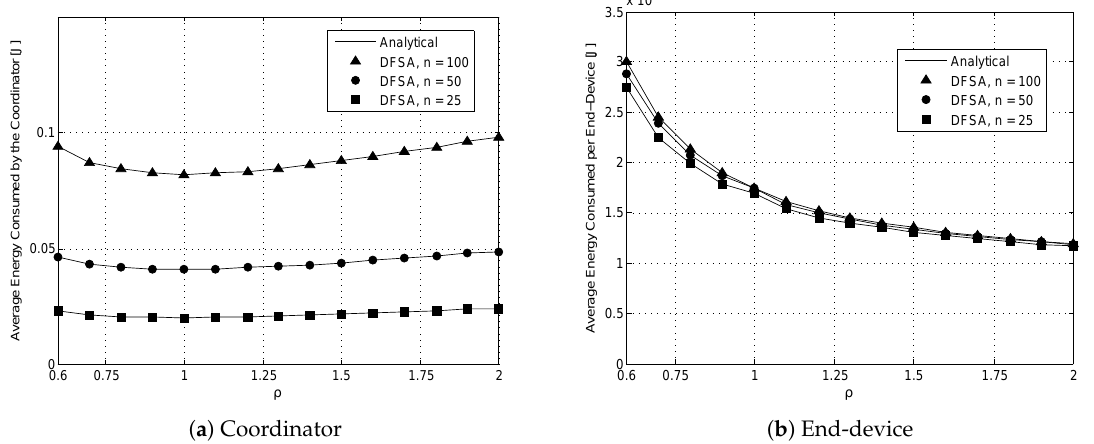
Figure 7. DFSA coordinator and end-device average energy consumption depending on ρ